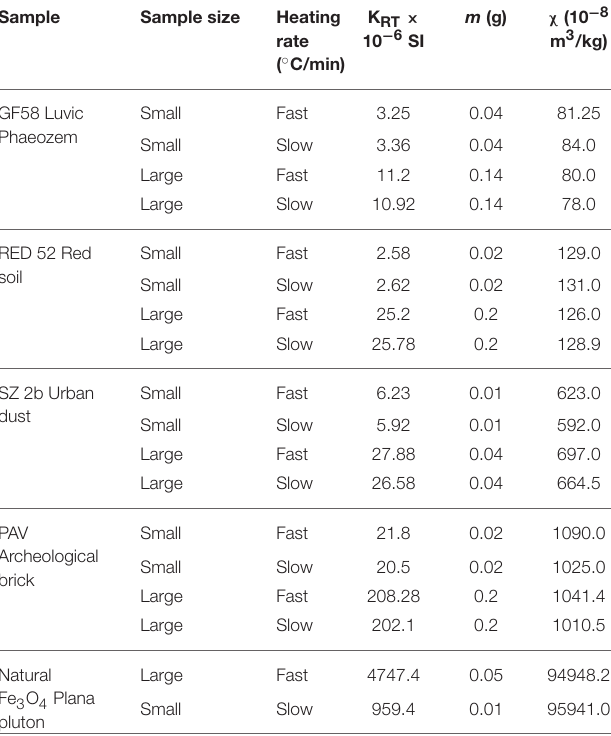
TABLE 1 | Volume (K RT ) and mass-specific ( χ ) magnetic susceptibilities of samples used in thermomagnetic analyses with small and large sample sizes.